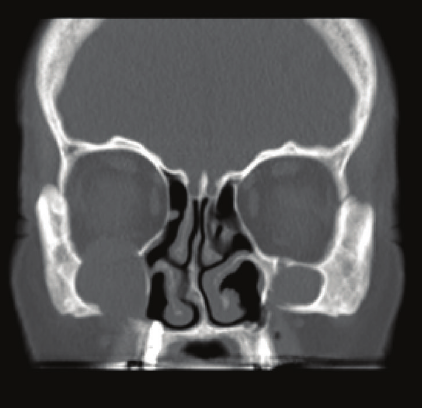
Figure 5: CT: coronal view showing osseous defects in the nasal part of the right sinus and the orbital floor.